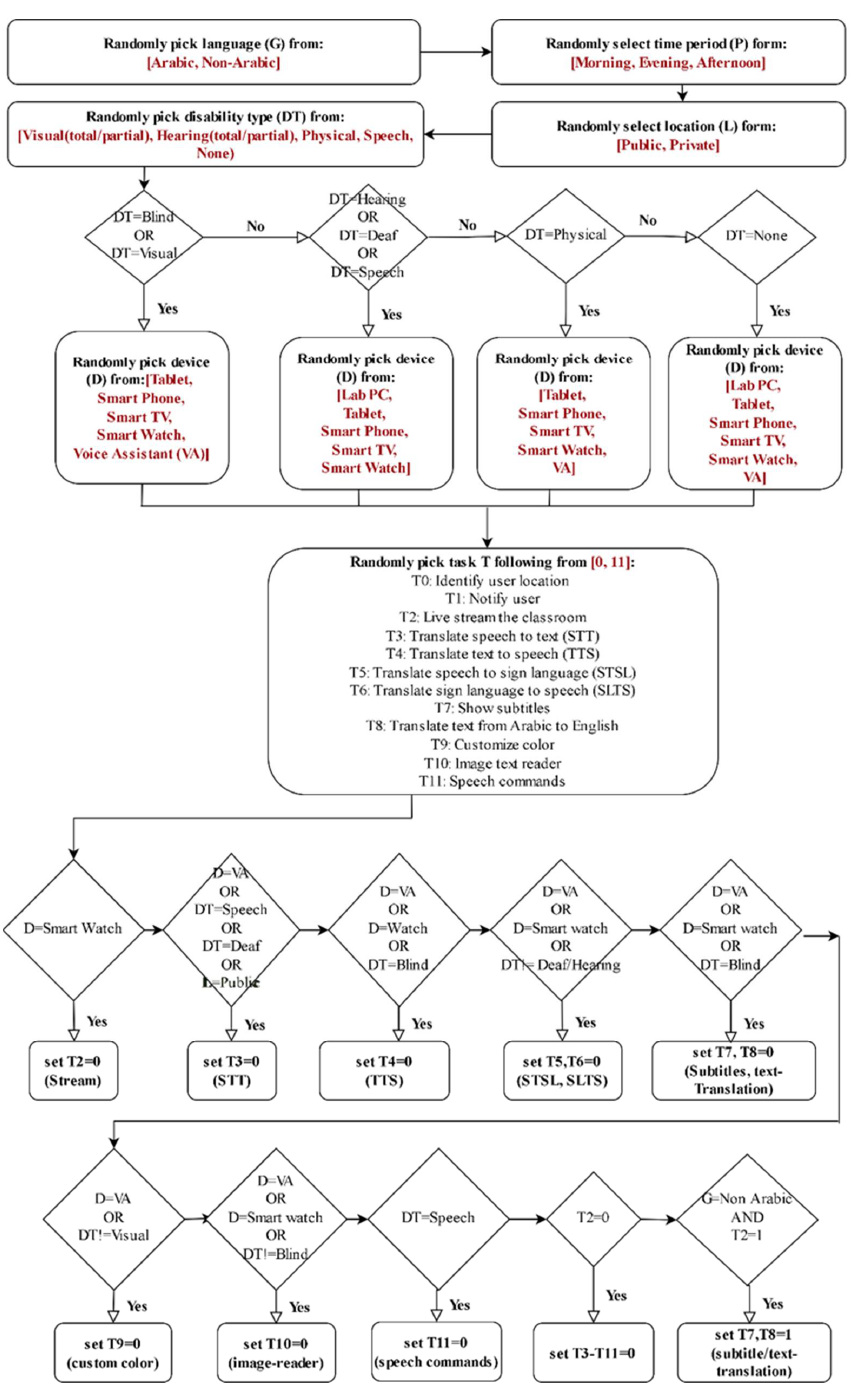
Figure 3. Heuristics for generating the first dataset. The dataset contains 1000 disabled users with differing attributes and 12 user tasks. T = tasks, DT = disability type, D = service, G = language, P = time period, L =